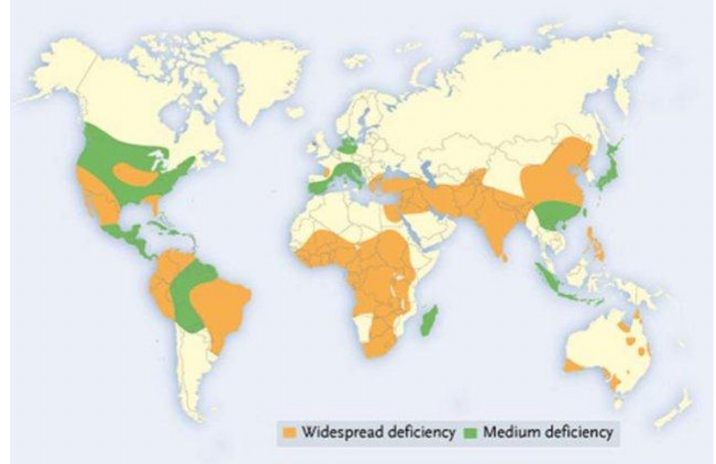
Figure 1. Geographical distribution of low Zn soil section in the world (adapted from Alloway, 2008). Alloway, B.J, (2004). Zinc in soils and crop nutrition. Brussels, Belgium: International Zinc Association